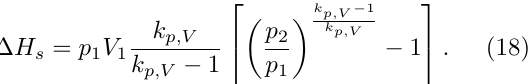
p on temperature for